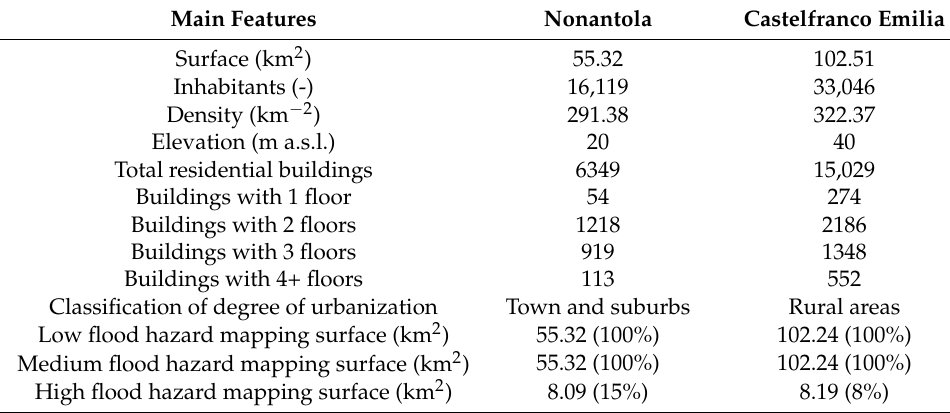
Table 5. Main characteristics of the case study